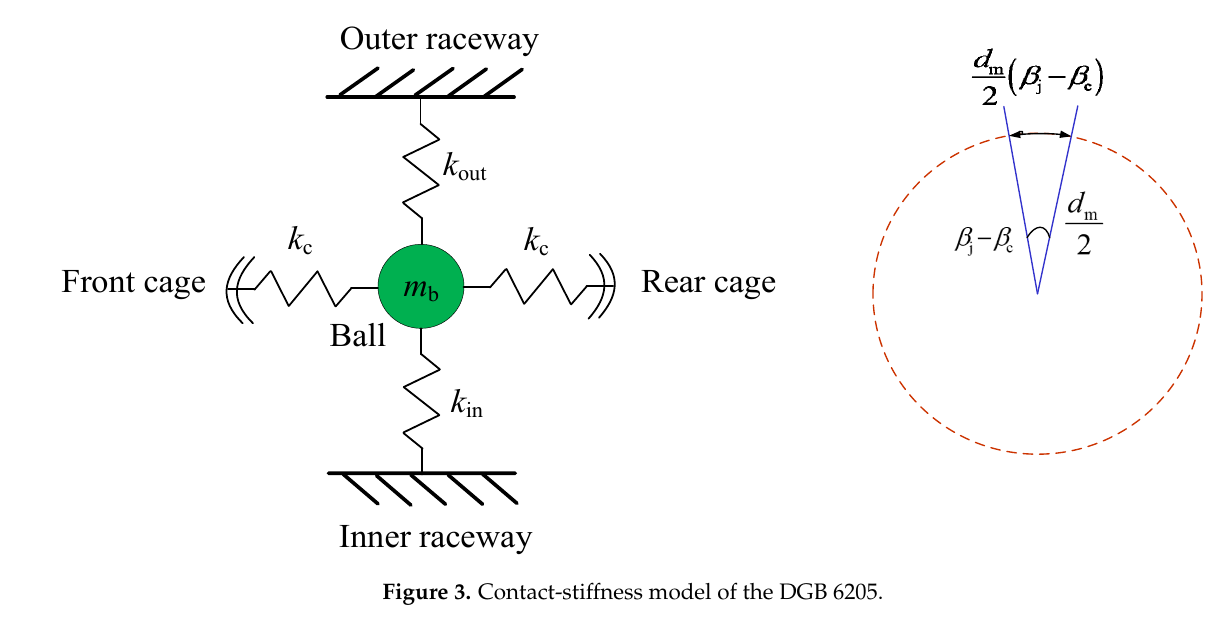
Figure 3. Contact-stiffness model of the DGB 6205.